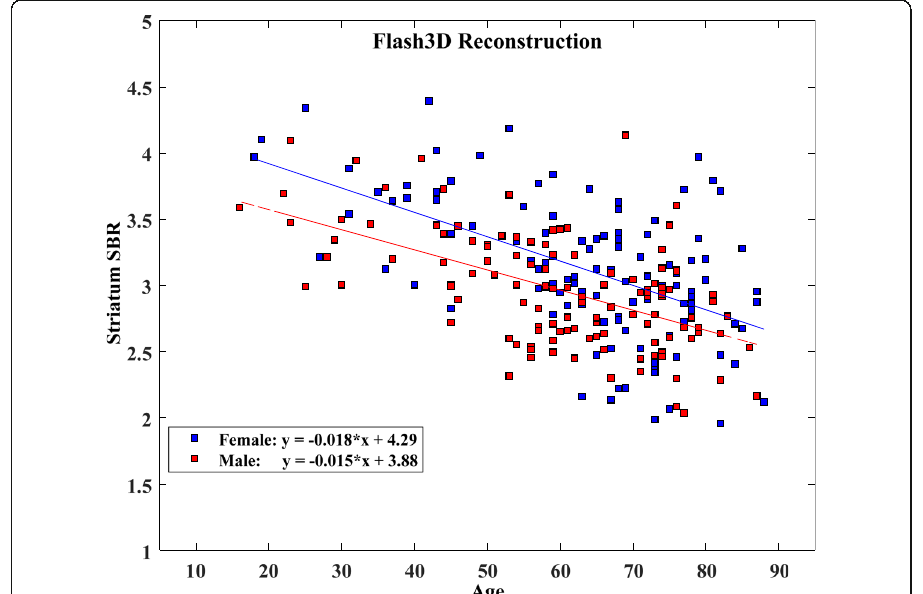
Fig. 3 Effect of age and gender on specific binding ratio (SBR) values computed as the average of left and right SBRs within the striatum and plotted as a function of age. Also shown are regression lines with slope and intercept for the Flash3D database (female, blue; male,